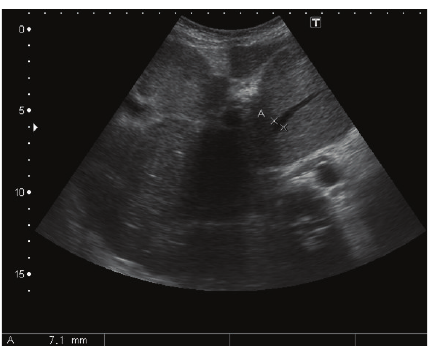
Figure 22: Prominent caudate lobe vein (marked by calipers; measuring 7 mm) in setting of BCS.